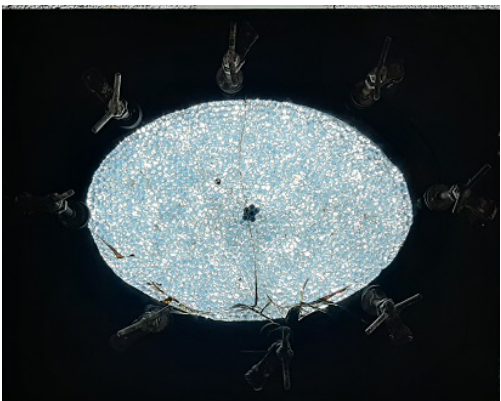
Figure 7. Actual dry elliptic chamber made in a 3.18 cm (1.5”) thickness cast iron slab.